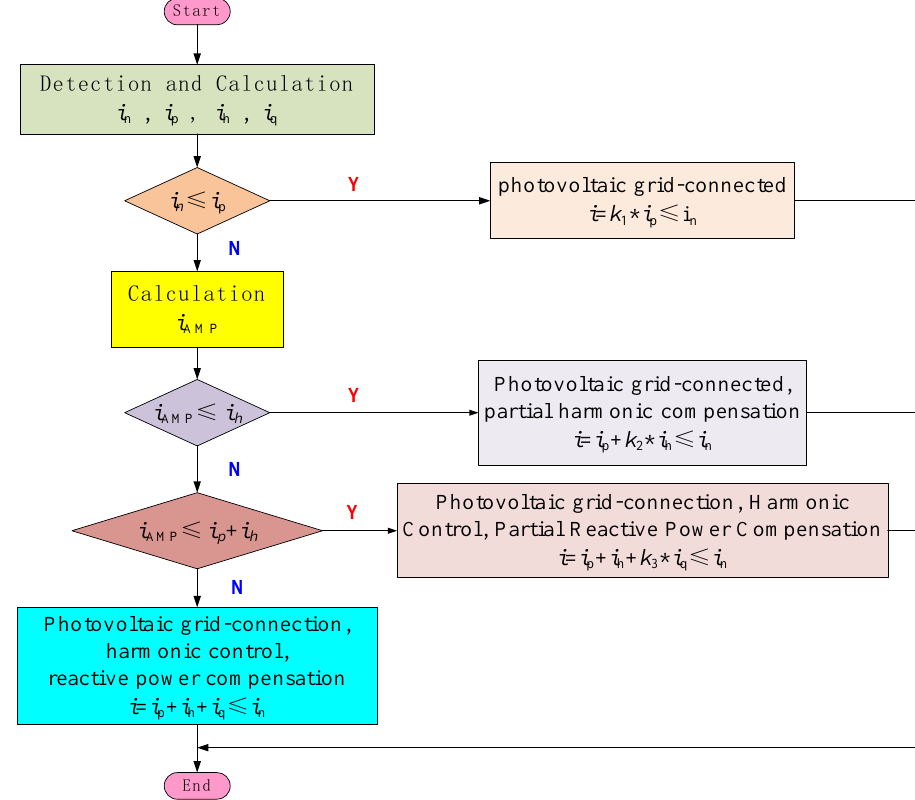
Figure 9. The flow diagram of power quality control for photovoltaic grid-connected. In order to solve the leakage current problem of the two-stage photovoltaic grid- connected and power quality control system, the intermediate DC bus adopts two equal capacitors, and the grid-connected end and the midpoint of the DC bus are grounded. The improved two-stage system diagram is shown in Figure